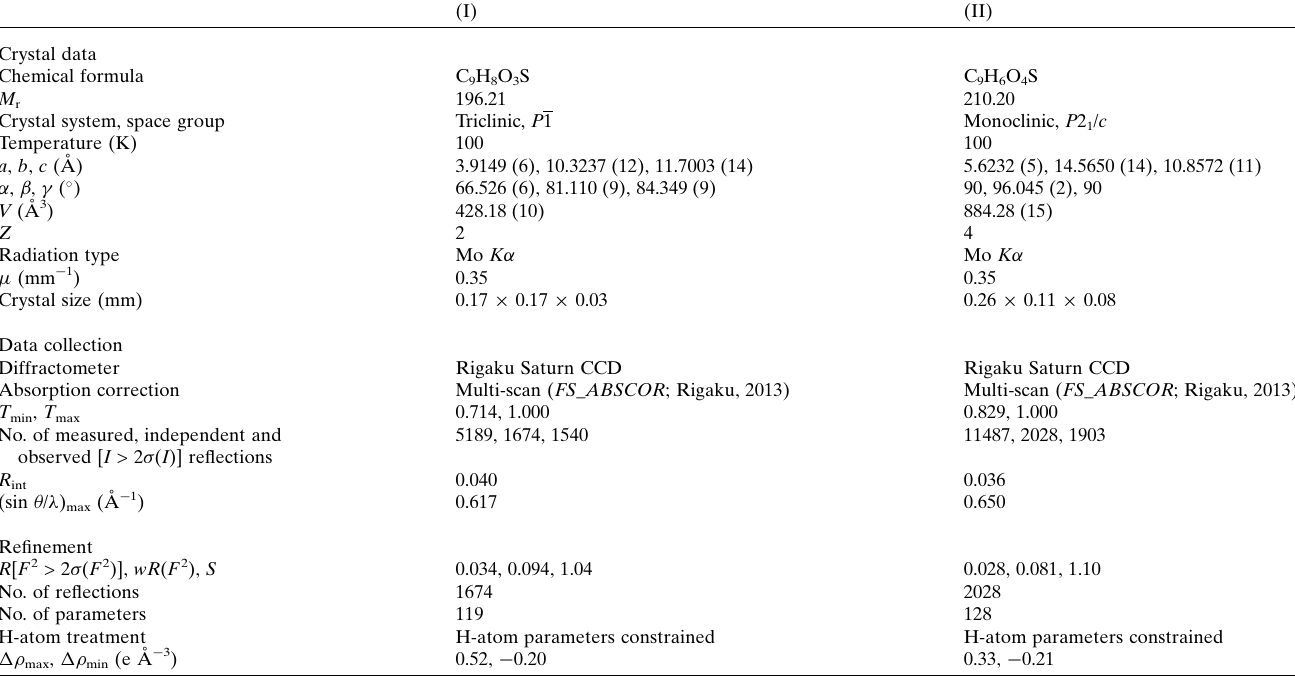
Table 4 Experimental